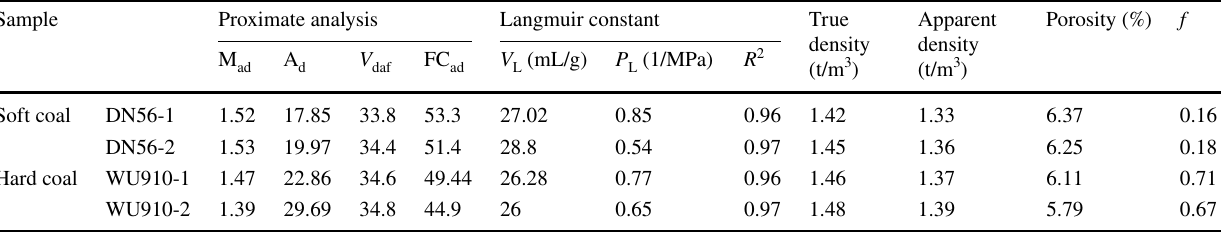
Table 1 Values of physical parameters